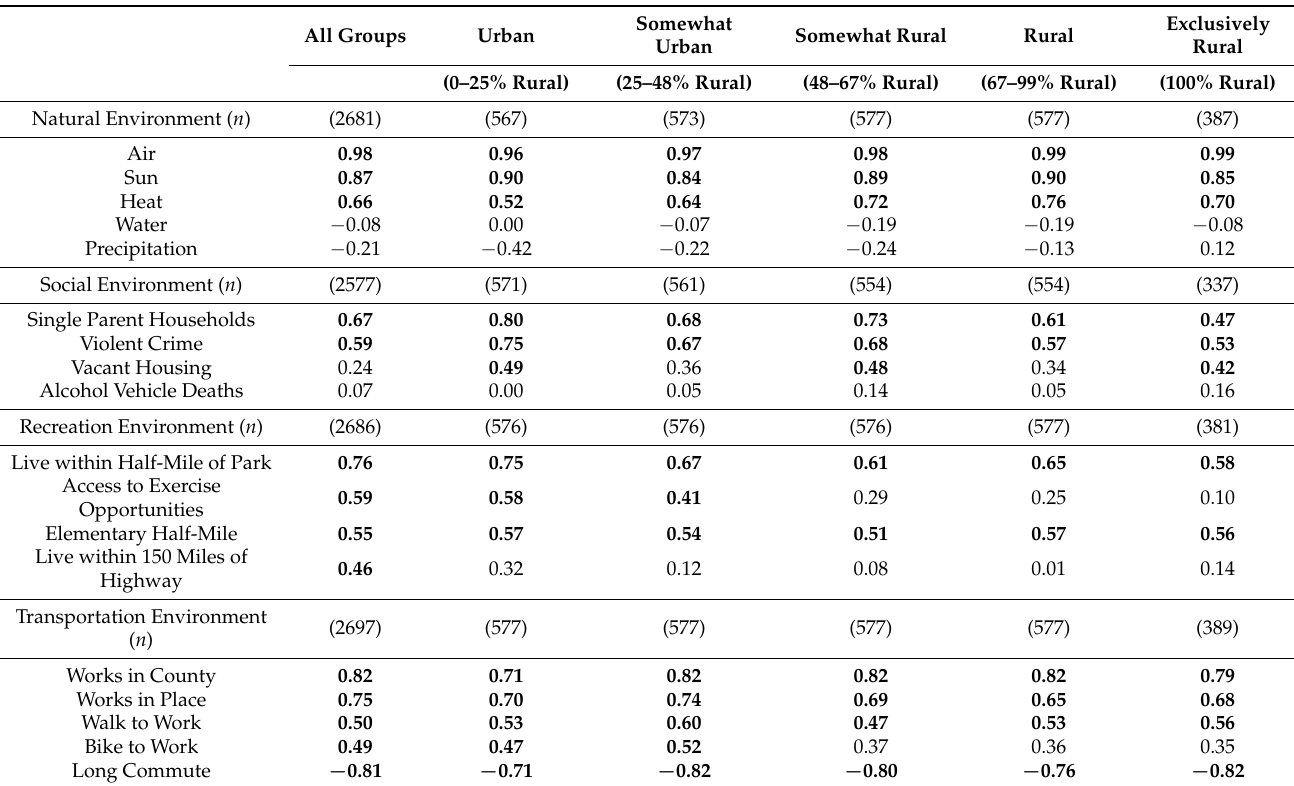
Table 3. Exploratory Factor Analysis Factor Loadings.